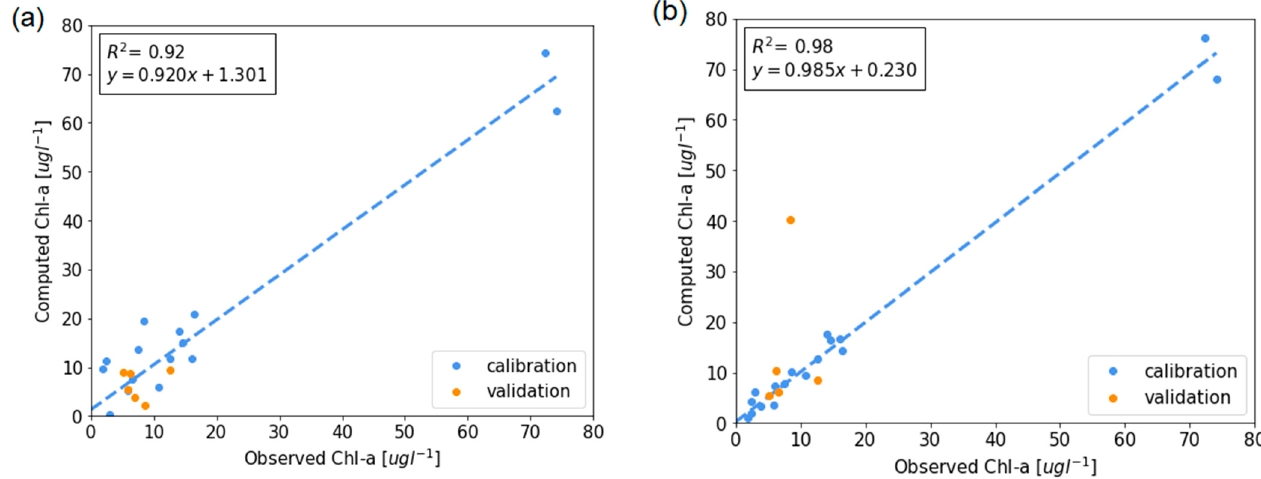
Figure 4. Computed vs. observed Chl-a concentrations for the spring-summer period, with the max- imum recorded concentrations included: ( a ) Chl-a calculated using TOA data (L1C) and ( b ) Chl-a calculated using BOA data (L2A). Dashed lines correspond to the perfect agreement between com- puted and observed Chl-a concentrations.